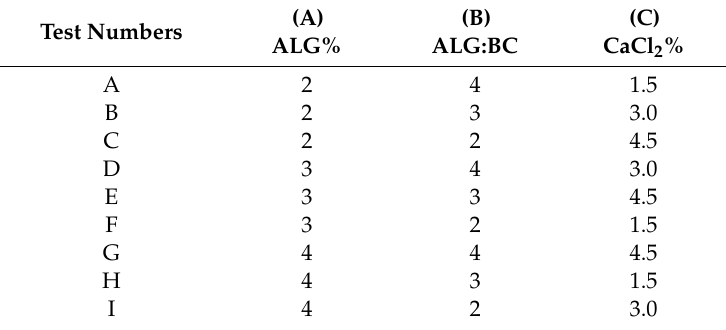
Table 1. The di ff erent composition of the BC-ALG carriers.